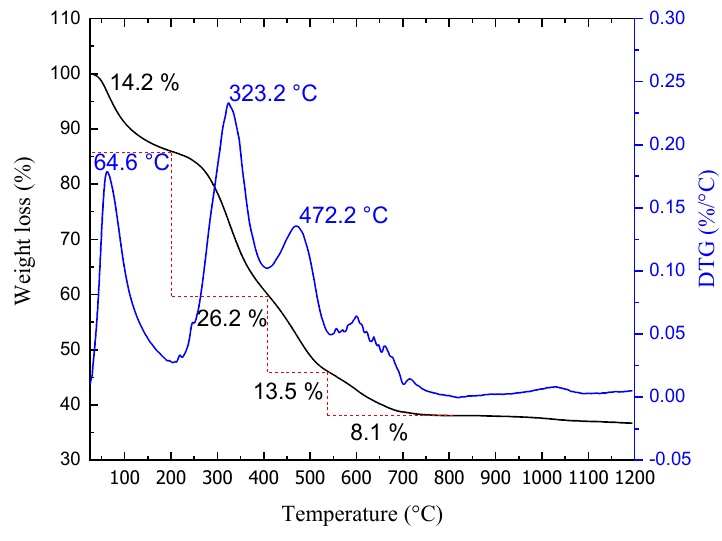
Figure 2. Thermogravimetric analysis.